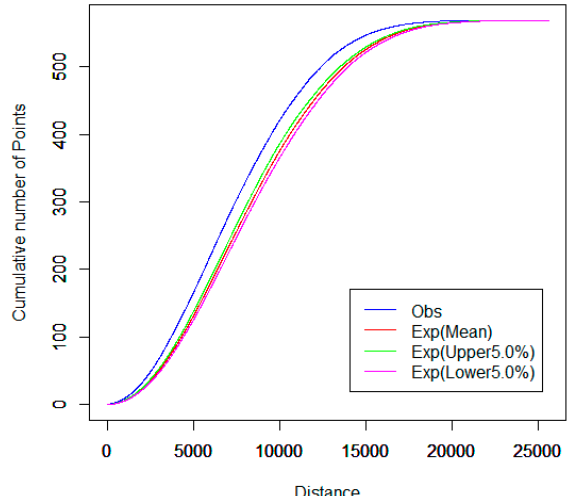
Figure 6. Network cross K-function analysis between hospitals and pharmacy stores in main urban